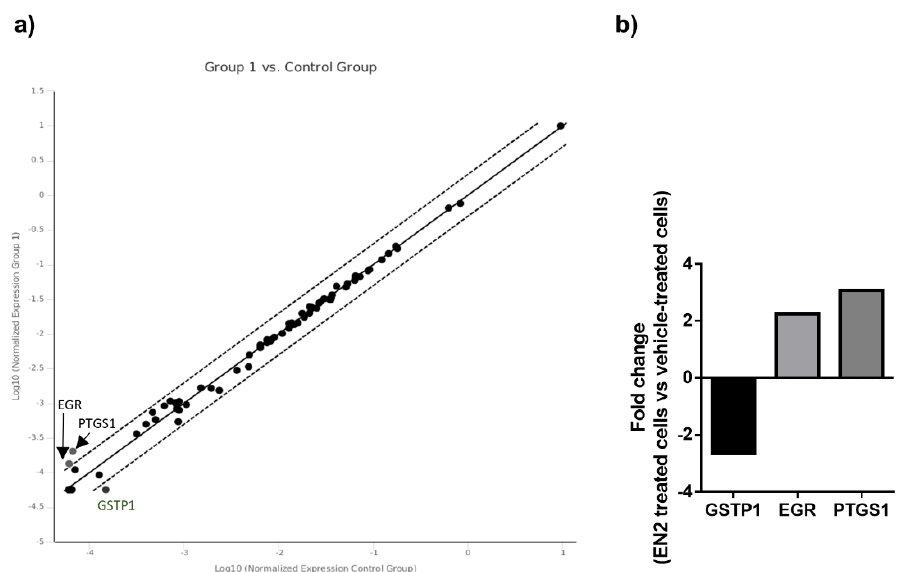
Figure 4. PCR array of human AR signaling pathway. ( a ) Representation of differences (two-fold change) between control and EN2-treated LNCaP cells using scatter plot. Upregulated genes are at the top of the image and downregulated genes at the bottom. ( b ) Representation of log 2 fold changes in significantly-altered genes [Glutathione S-transferase P 1 ( GSTP1 ), Early growth response 3 ( EGR3 ), and Prostaglandin-Endoperoxide Synthase 1 ( PTGS1 )] between control and EN2-treated LNCaP cells.